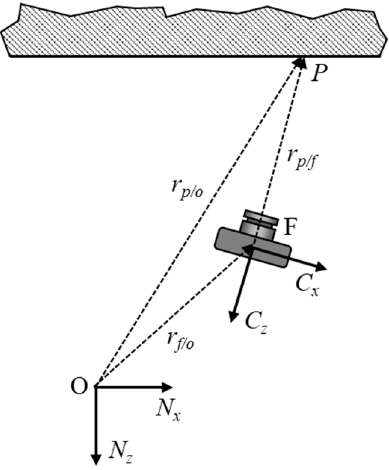
Figure 3. Relationship between the camera focal point, the origin, and the optical axis projection onto the surface above.